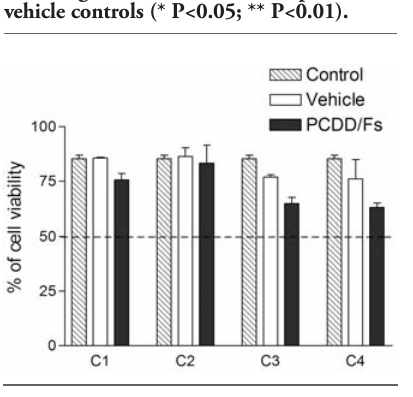
Figure 5. Effects of various concentrations of polychlorinated dibenzo -p- dioxins/ diben- zofurans (PCDDs/Fs) on the viability of the extruded cells of E. andrei